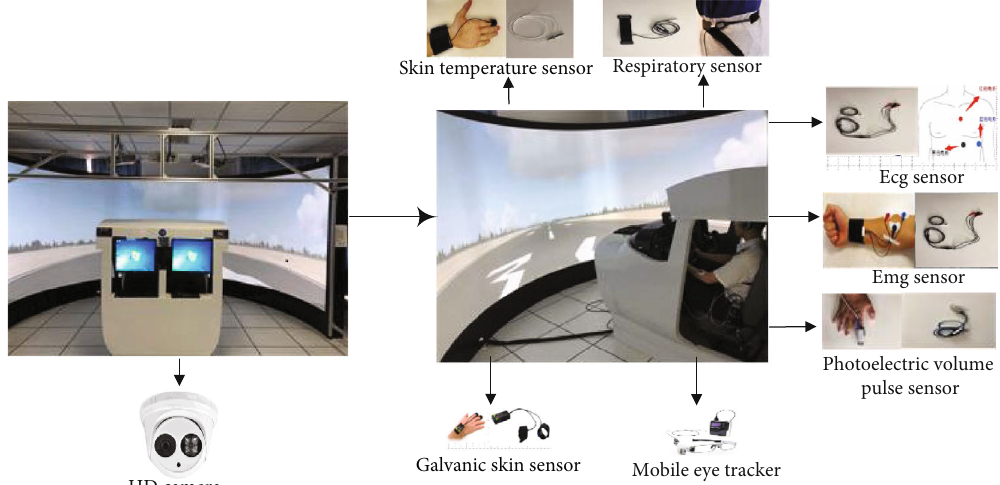
Figure 2: Dynamic acquisition system for comprehensive human-aircraft-environment